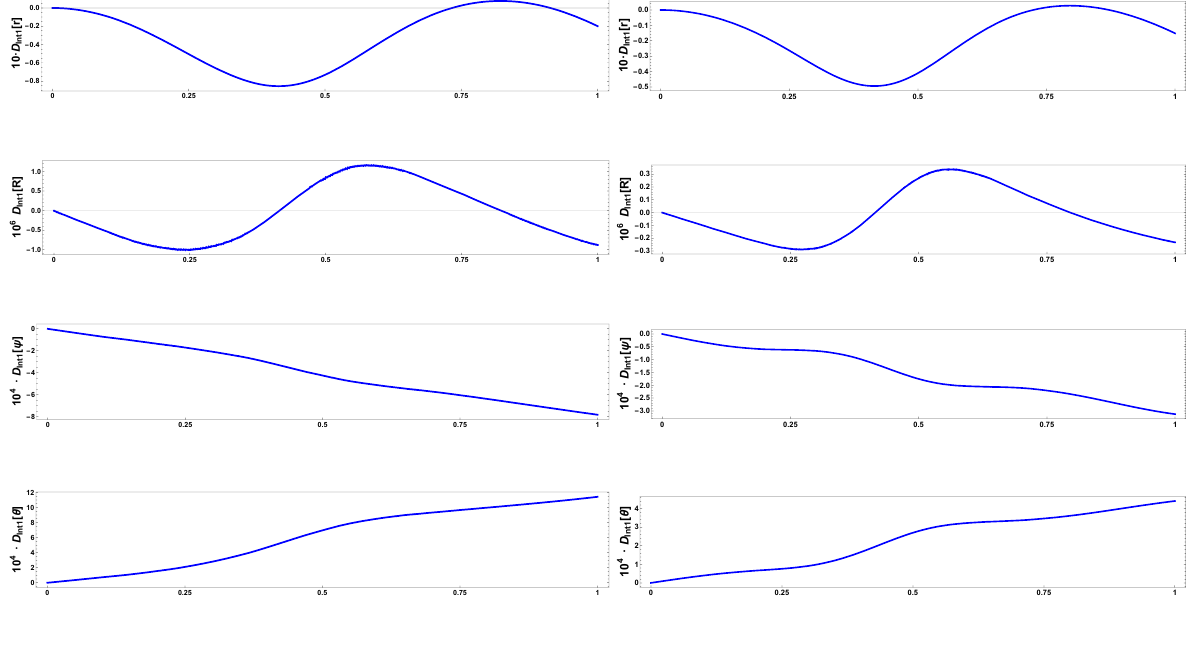
Fig. 5 Left column ( H = 1000 Km , T = 22 . 8 h ) and right column ( H = 2000 Km , T = 10 . 8 h ) , where T is the orbital period expressed in hours. Abscissas are orbital periods and D [ x ] = x Full − x